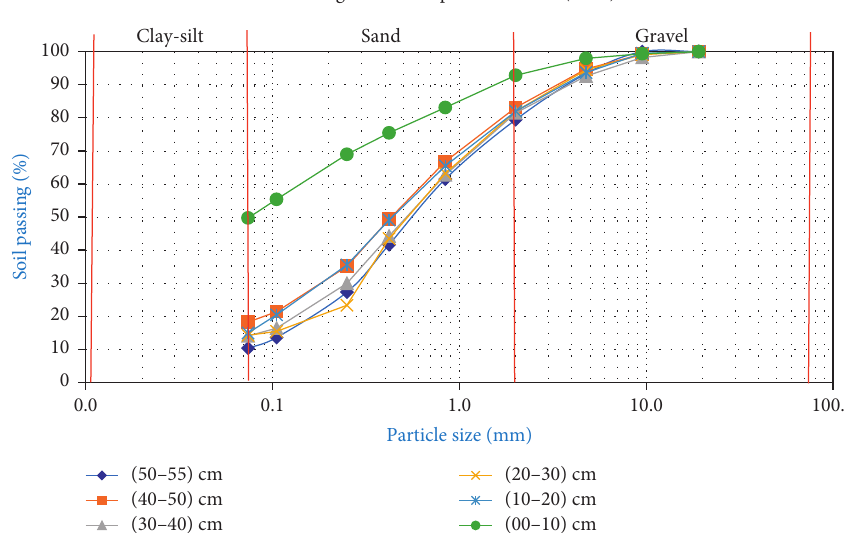
Figure 3: The sieve analysis grading curves of the sample from location